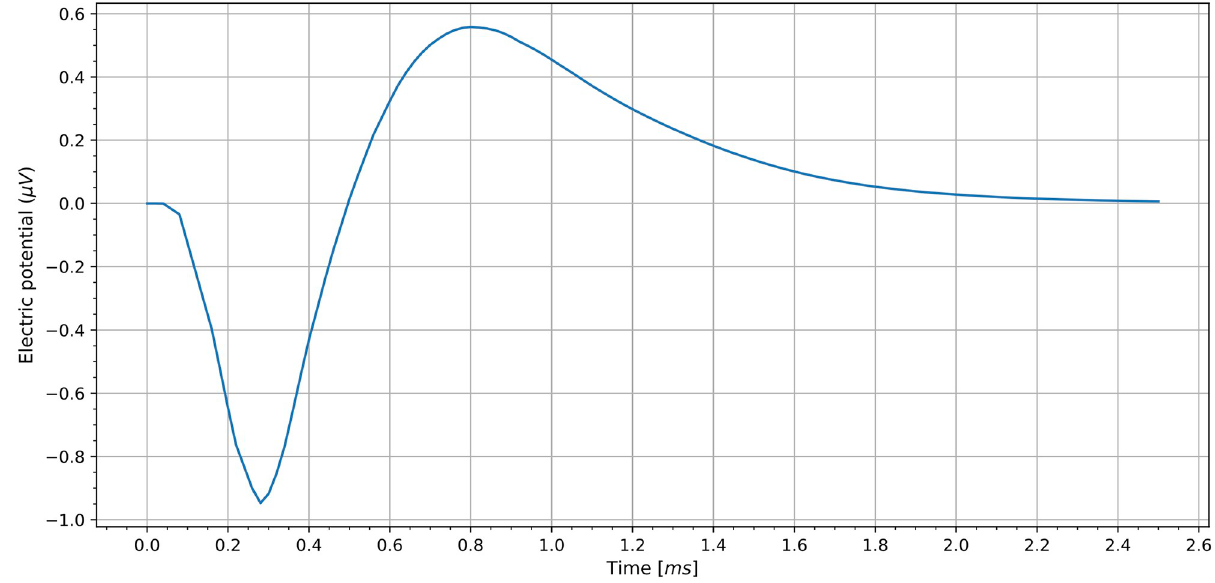
Fig 7. ECAP generated by VN number 0 at electrode 2 for a propagation velocity v = 15 m s − 1 .